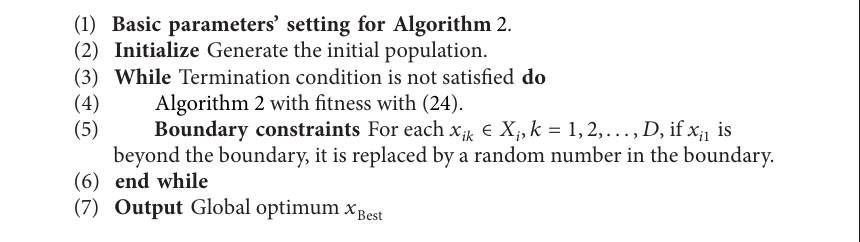
Algorithm 3: A novel unknown parameters and orders identification method based on differential evolution algorithms for noncommen- surate and hyperfractional-order chaos systems.